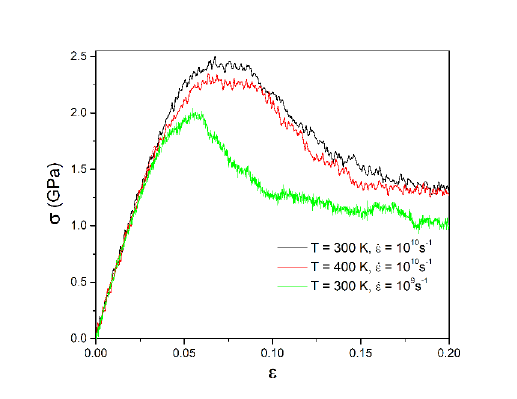
Figure 7. Effect of temperature and strain rate on stress-strain curves of Cu Zr Ti 60.0 32.5 7.5